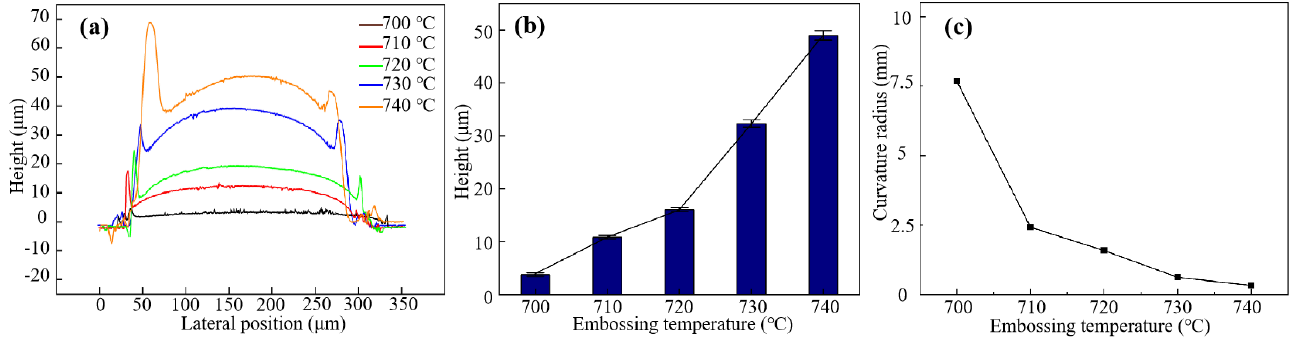
Figure 8. ( a ) Profiles, ( b ) maximum heights, and ( c ) curvature radii of microlenses under various embossing temperature.